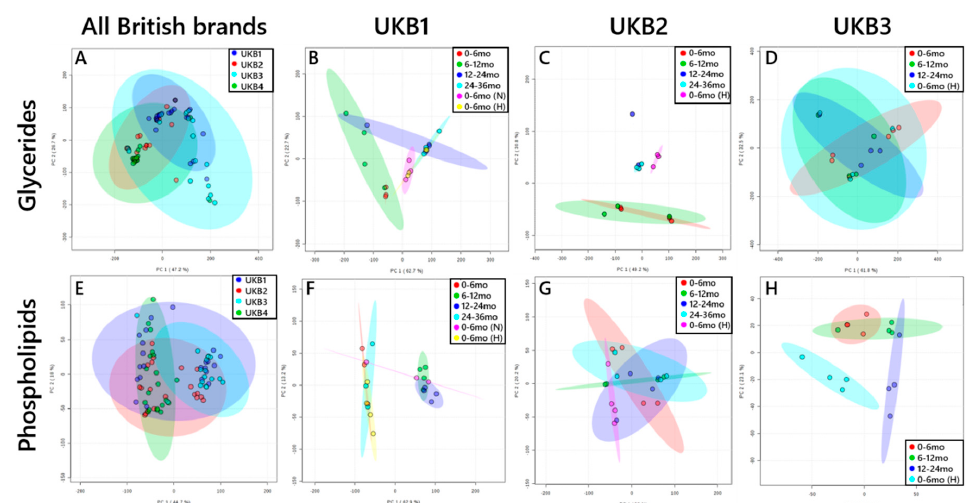
Figure 1. Principal component analyses (PCAs) of infant formulae sold in the UK (2017–2019). Panels ( A–D ), triglycerides and diglycerides: ( A ), All brands; ( B ), British brand 1 (UKB1); British brand 2 (UKB2); British brand (UKB3). Panels E-H, phospholipids: ( E ), All brands; ( F ), British brand 1 (UKB1); ( G ), British brand 2 (UKB2); ( H ), British brand (UKB3). R 2 values for each component are shown in parentheses on each axis. H, ‘hungry’; N, ‘night’. Nutrients 2019 , 11 , x FOR PEER REVIEW